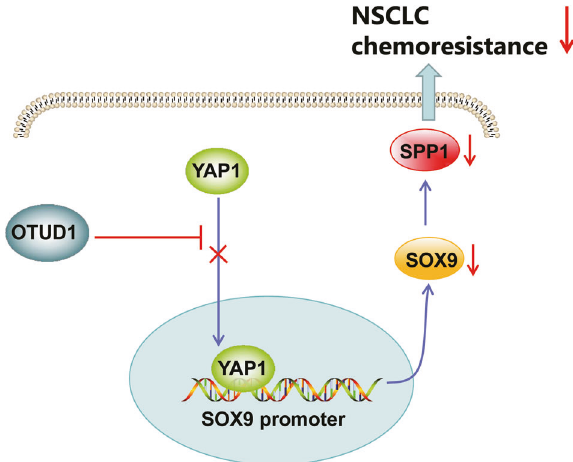
Fig. 6 Schematic diagram of the mechanism by which OTUD1 affects the resistance of NSCLC cells to erlotinib. OTUD1 inhibits the nuclear translocation of YAP1 and inactivates the SOX9/SPP1 axis, ultimately reversing the resistance of NSCLC cells to